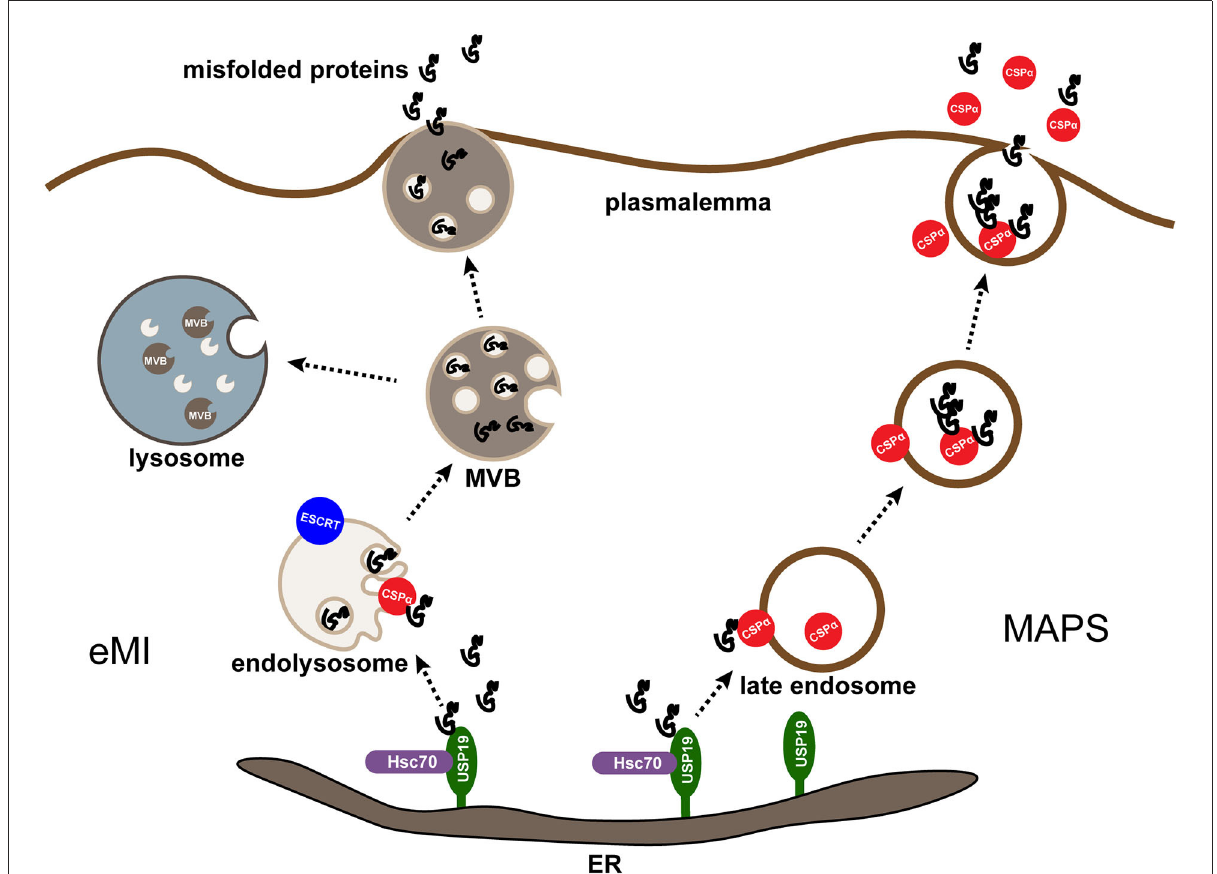
FIGURE2 MAPS and eMI are two parallel pathways mediated by CSP α . Misfolding-associated protein secretion (MAPS) and endosomal microautophagy (eMI) are two protein quality control (PQC) mechanisms mediated by CSP α in mammalian cells. In both cases, an ER-associated deubiquitinase USP19 recruits misfolded substrates at the ER. For MAPS, misfolded proteins enriched in the ER by interacting with USP19 are transported to CSP α on the late endosome and taken up by endocytosis, subsequently they are transported to the plasmalemma for secretion and degraded in lysosomes from another cell. For eMI, CSP α escorts misfolded proteins into endolysosomes by an ESCRT-dependent mechanism. The resulting multivesicular bodies containing misfolded cargos can be degraded or secreted after the fusion of multivesicular bodies (MVBs) with lysosomes or plasma